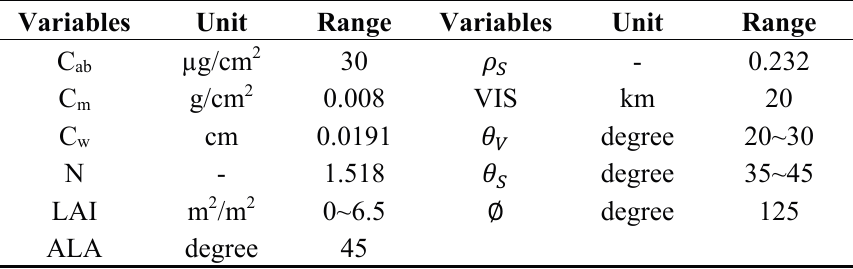
Table 3. The PROSAIL input parameters.